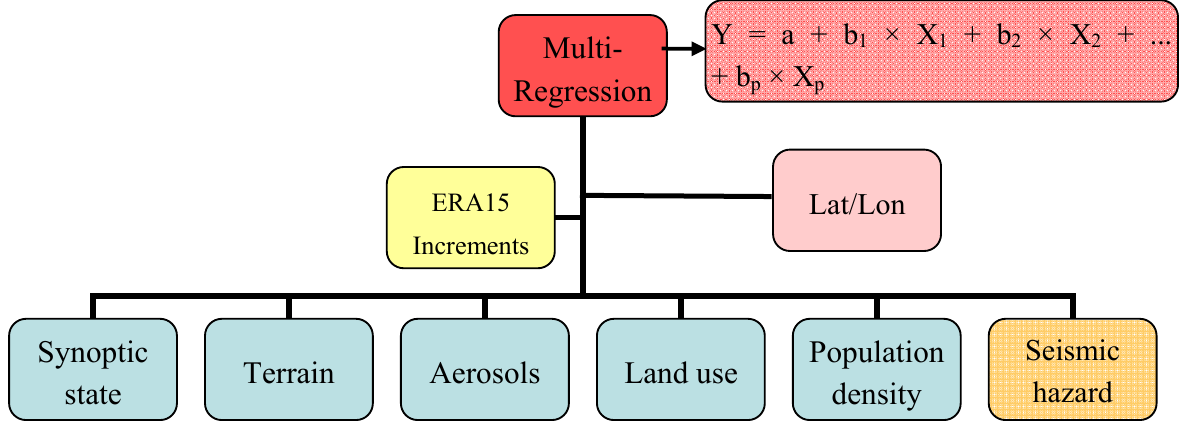
Figure 2. Flow chart of the multi-regression procedure; Y is the dependent variable (ERA15 increments), which can be expressed in terms of a constant ( a ) and slopes ( b ) times each of the independent X variables (TOMS, omega, topography, seismic hazard (marked with orange for being the dummy variable), population density and land use